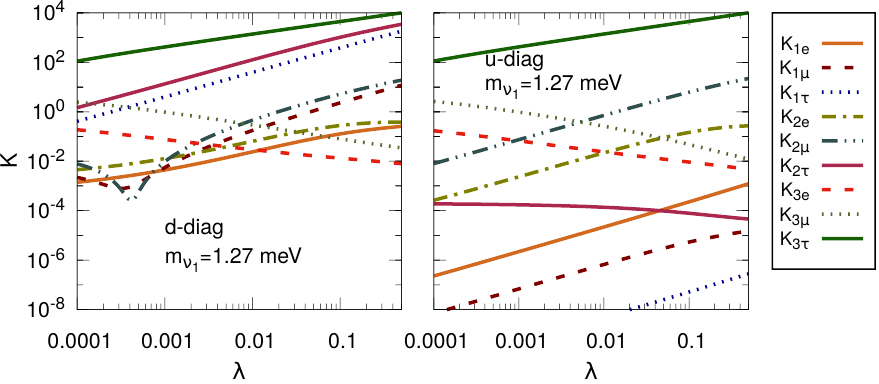
Figure 6 . Washout factor vs. quartic coupling in the compact spectrum scenario. Left(right) panel corresponds to d ( u )-quark diagonal basis. The lightest neutrino mass is kept at m (cid:23) Other parameters are kept (cid:12)xed as described in the